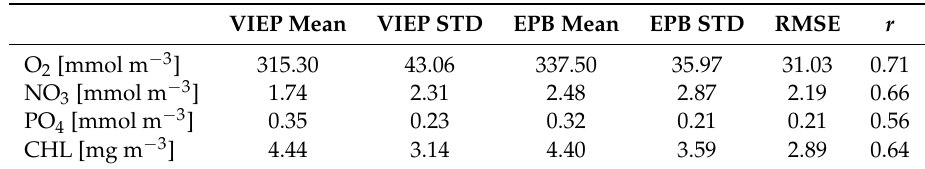
Table 3. Statistical comparison of EcoPuckBay model with Voivodship Inspectorate of Environmental Protection (VIEP) monitoring data. VIEP Mean VIEP STD EPB Mean EPB STD